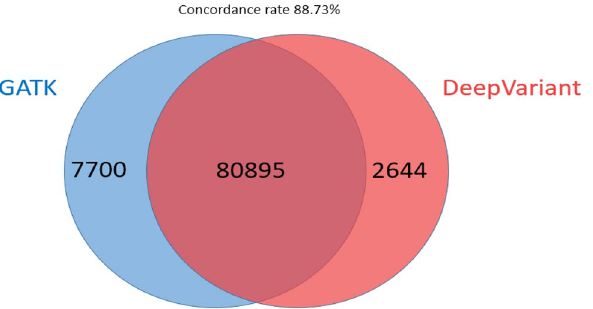
Figure 3. Venn diagram of variants identified by the two different pipelines (the number indicates the mean from 231 exomes; n = 77 trios).